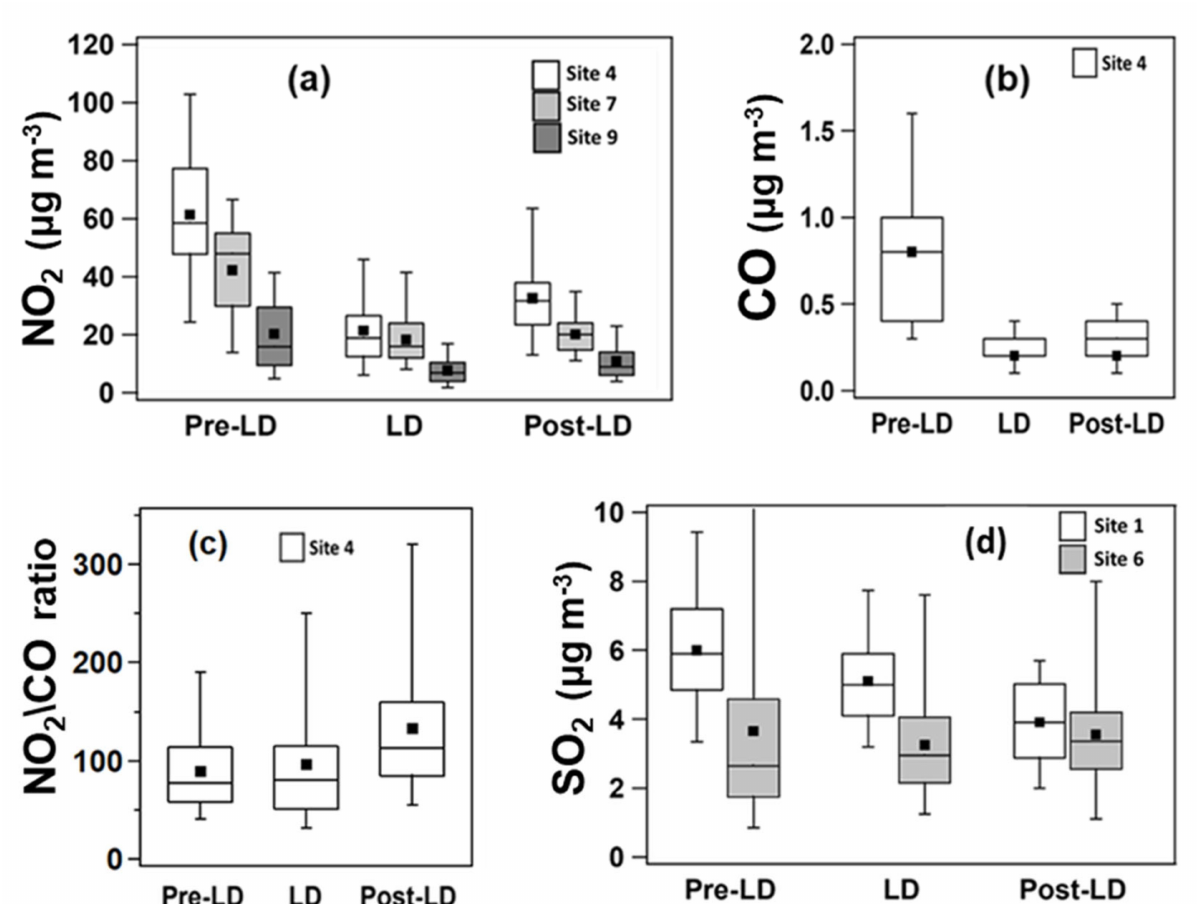
Figure 9. ( a ) Box plots of NO 2 mass concentration for Sites 4 (Lecce—Libertini, white boxes), 7 (Campi Salentina, light grey boxes), and 9 (Cerrate, dark grey boxes) in the Pre-LD (before lockdown), LD (during lockdown), and Post-LD (after lockdown) periods. Box plots of ( b ) CO mass concentration and ( c ) NO 2 /CO ratio for Site 4 in the Pre-LD, LD, and Post-LD periods. ( d ) Box plots of SO 2 mass concentration for Site 1 (Maglie, white boxes) and Site 6 (Surbo, grey boxes) in the Pre-LD, LD, and Post-LD periods. Horizontal lines and dots in each box are the median and mean values, respectively. The 25th and the 75th percentiles are indicated by the lower and the upper boundaries of each box, respectively. The lower and upper whiskers represent the 5th and the 95th percentiles,